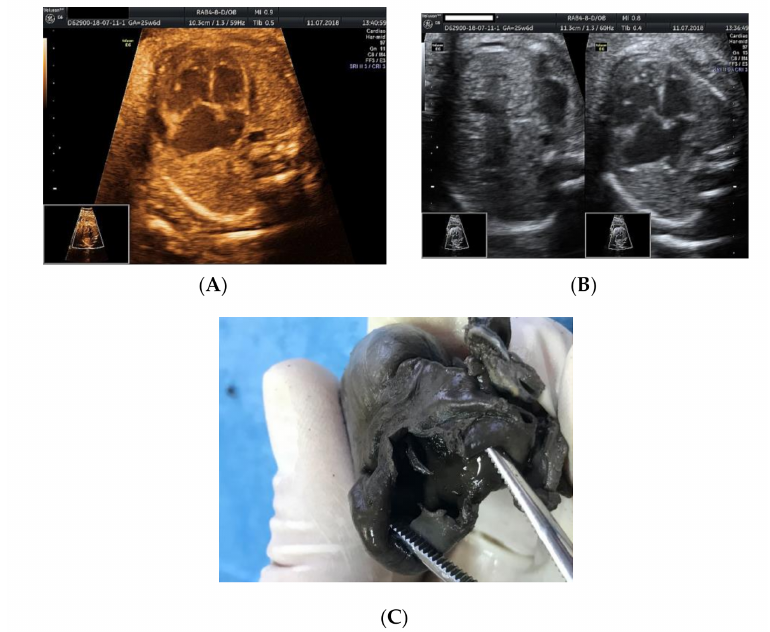
Figure 1. Cardiomegaly: ( A , B ) ultrasound assessment of the four-chamber view—enlarged right atrium, no foramen ovale noted, no atrial septum; ( C ) necropsy examination revealed one common atrium and no interatrial septum.